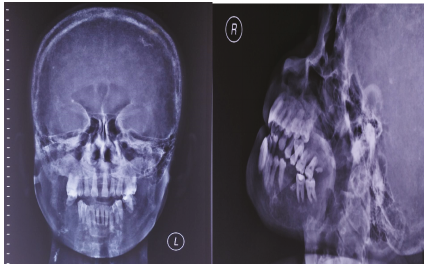
Figure 6: Case 2. Bone radiographic examination of the skull showing multiple lytic lesion among the calvaria, decreased di ff use bone density among the calvaria, and multiple lytic lesion in the calvaria, maxilla, and mandible. Salt and pepper appearance in the calvaria.